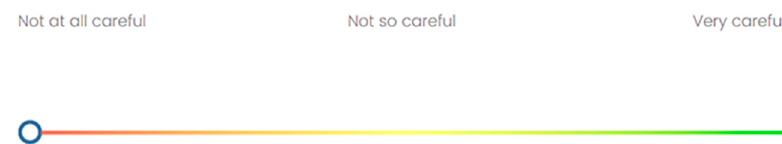
Figure 2. The multi-color communication scheme.